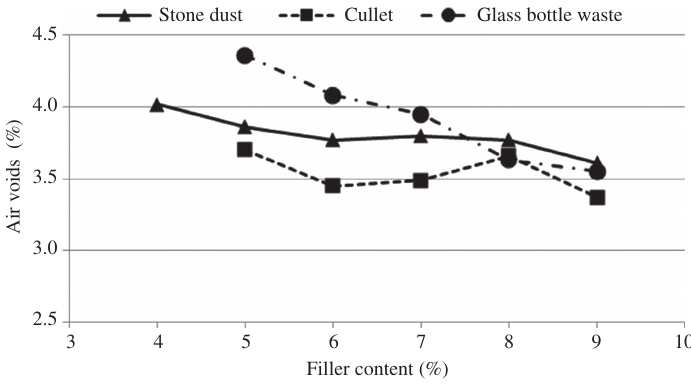
Figure 8 Relationship between air voids and filler ratio.